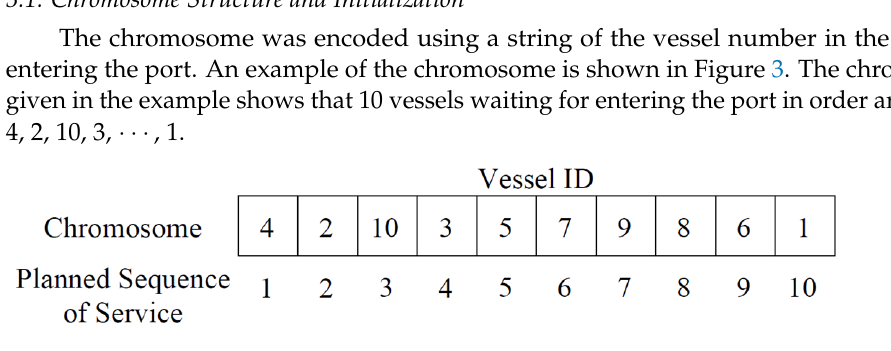
Figure 3. Chromosome structure representation.